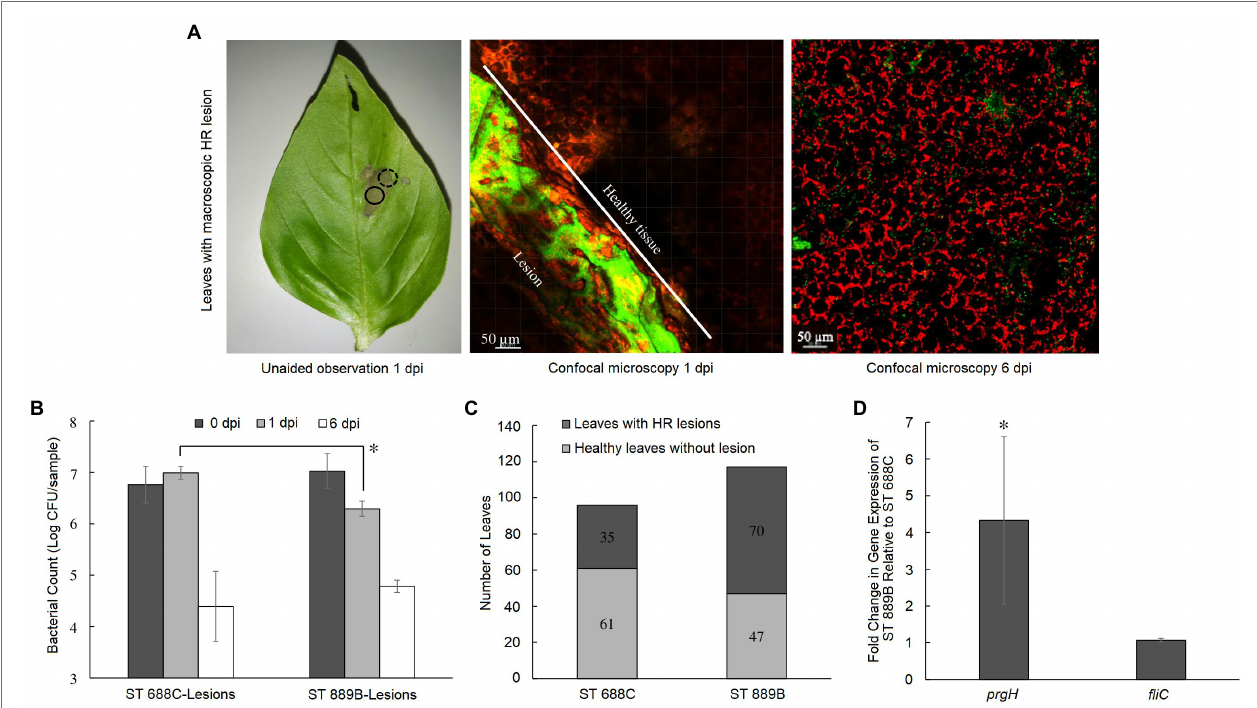
FIGURE 3 | (A) A representative basil leaf with macroscopic HR lesion as seen unaided at 1 dpi, and under confocal microscopy at 1 (dotted circle showing the border between healthy tissue and the lesion separated by the white line) and 6 dpi (full circle showing the lesion; from left to right) where red signals represent leaf cells while green signal represents GFP-tagged Salmonella cells; (B) bacterial counts of ST 688C and ST 889B on leaf tissue with HR lesion at 0, 1, and 6 dpi; (C) number of resultant healthy-looking leaves without HR and unhealthy leaves with HR following inoculation with ST 688C or ST 889B; (D) fold change in gene expression of select HR-related genes in ST 889B relative to ST 688C. Values linked by lines and denoted by * represent significant difference at p < 0.05 except in (D) , where * denotes significant difference ( p < 0.05) to a theoretical mean of 1, which is the relative gene expression level of ST 688C. Bacterial counts were the average of three experiments in (B) , while that of the fold change in gene expression in (D) was of two experiments. Data on the number of leaves with and without HR lesions upon inoculation with ST 688C and ST 889B (C) were derived across 10 and 12 different pre-harvest basil plants, respectively. Error bars denote standard